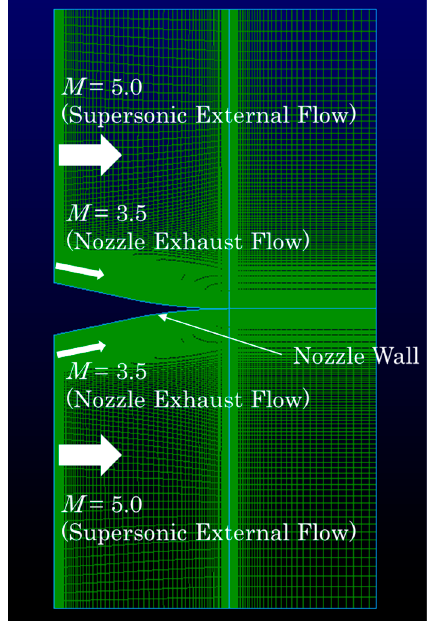
Figure 15. Mesh grids used for calculation of the flowfield of the advanced configuration. The flow direction is from left to right. The region of interest for computation is the area indicated by the grid.